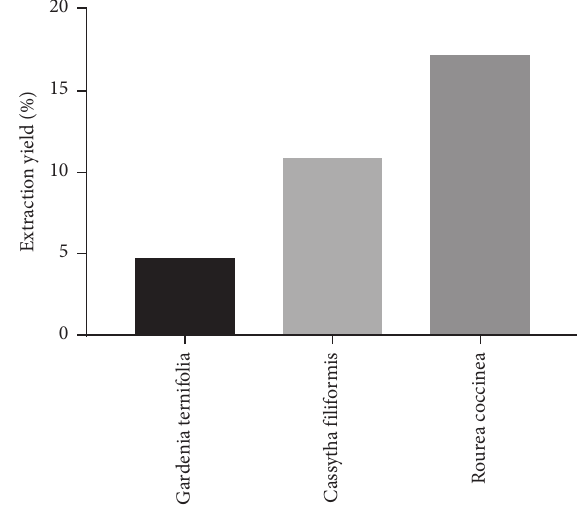
Figure 1: Extraction